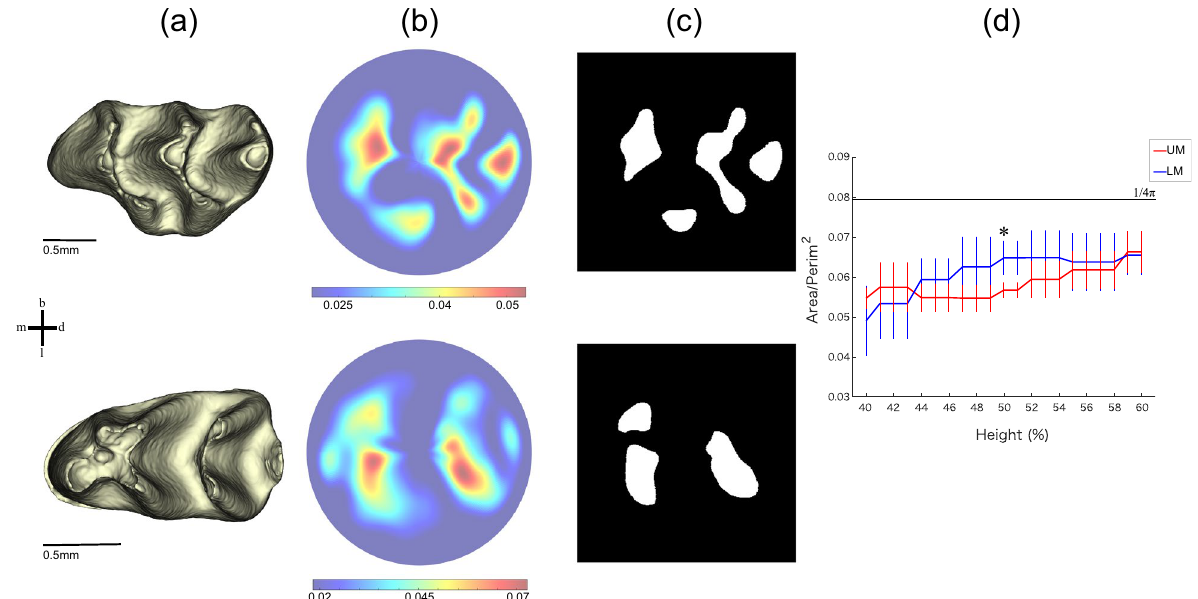
Figure 1. Scheme for 2D pattern extraction. ( a ) The 3D models of enamel–dentine junction. The three- dimensional surface models derived from µCT data were visualized by an in-house program, ForMATit, developed by N.M. [MATLAB-based (MathWorks, Version R2021b, https:// www. mathw orks. com/ produ cts/ matlab. html)]. ( b ) Morphometric maps of the height from the cervical plane in UM and LM. ( c ) Binarized image at 50% of total height. White regions are above the threshold. Top and bottom panels show UM and LM, respectively. m mesial, d distal, b buccal, l lingual. ( d ) A dimensionless index calculated as area/squared perimeter is used to distinguish between stripe and spot patterns. Significant differences between UM and LM were detected (the number of samples, n = 10 for each of UM and LM; the probability of null hypothesis by Kruskal–Wallis test, p < 0.001) at 40–60% of the total height from the cervical plane. The mean and standard deviation at each threshold level are indicated with a polygonal line and whisker, respectively. The asterisk indicates the threshold at the 50% level where binarized images of ( d ) are derived. The black line indicates a constant in the case of circle